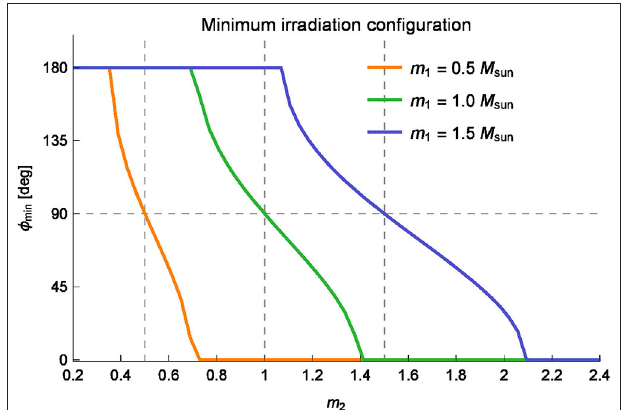
FIGURE 2 | Angle φ min for the minimum planetary insolation configuration against the mass of the secondary star m 2 for various masses of the primary star m 1 . We assume a planet on a circular orbit at a distance of 2.37 au from the binary barycenter, while the binary stars are evolved on a circular orbit with a semi-major axis of 1